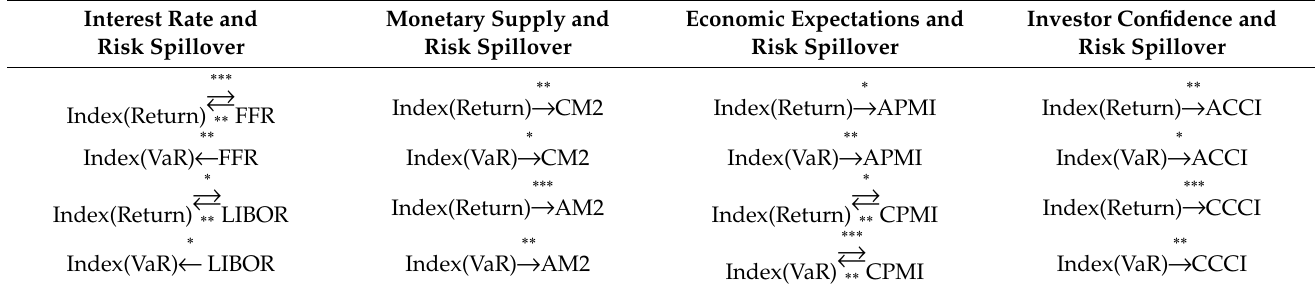
Table 7. Causality test of risk contagion.